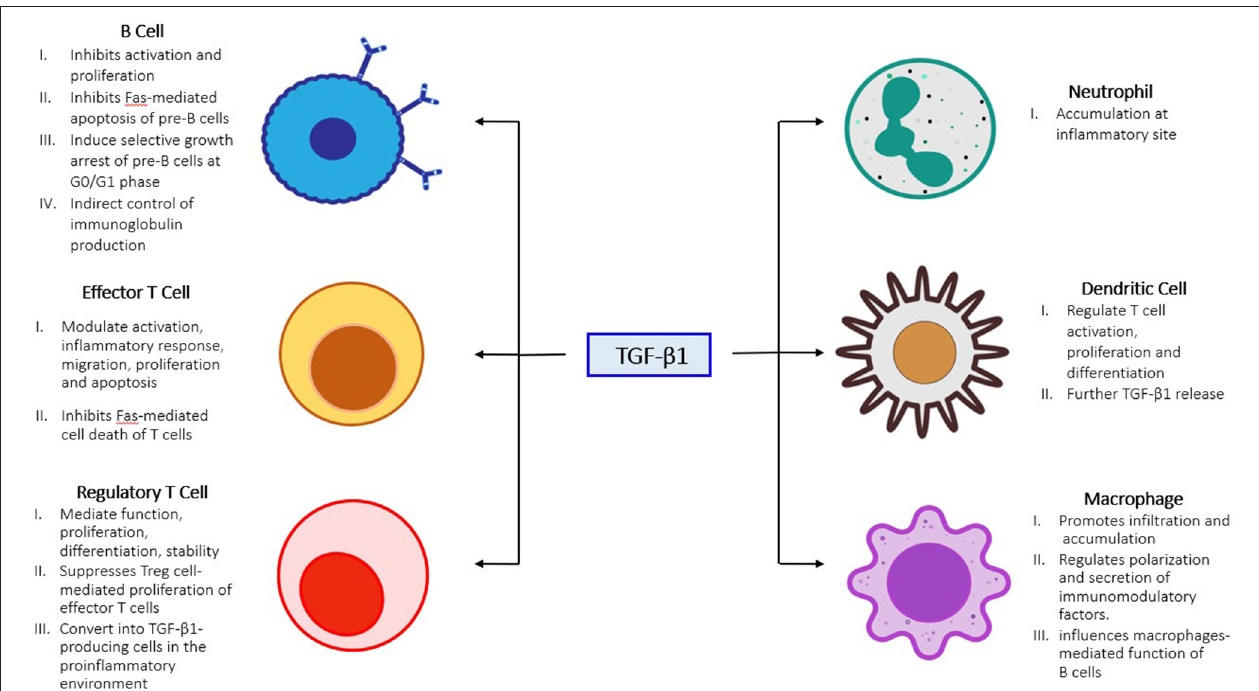
FIGURE 2 | Role of TGF- β 1 in unresolved inflammation. TGF- β 1 activation promotes innate immune cells accumulation (neutrophil, macrophage, and dendritic cell) at the inflammatory site, which in-turn further activate adaptive immune cells (B and T cells) and dendritic cells to amplify the inflammatory responses in chronic inflamed